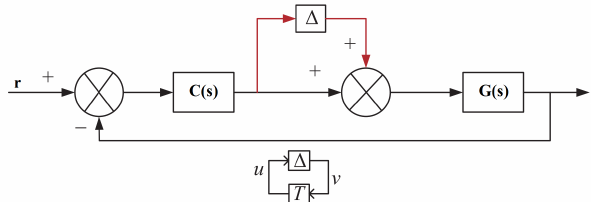
Figure 4. Multiplicative input uncertainty schematic structure.